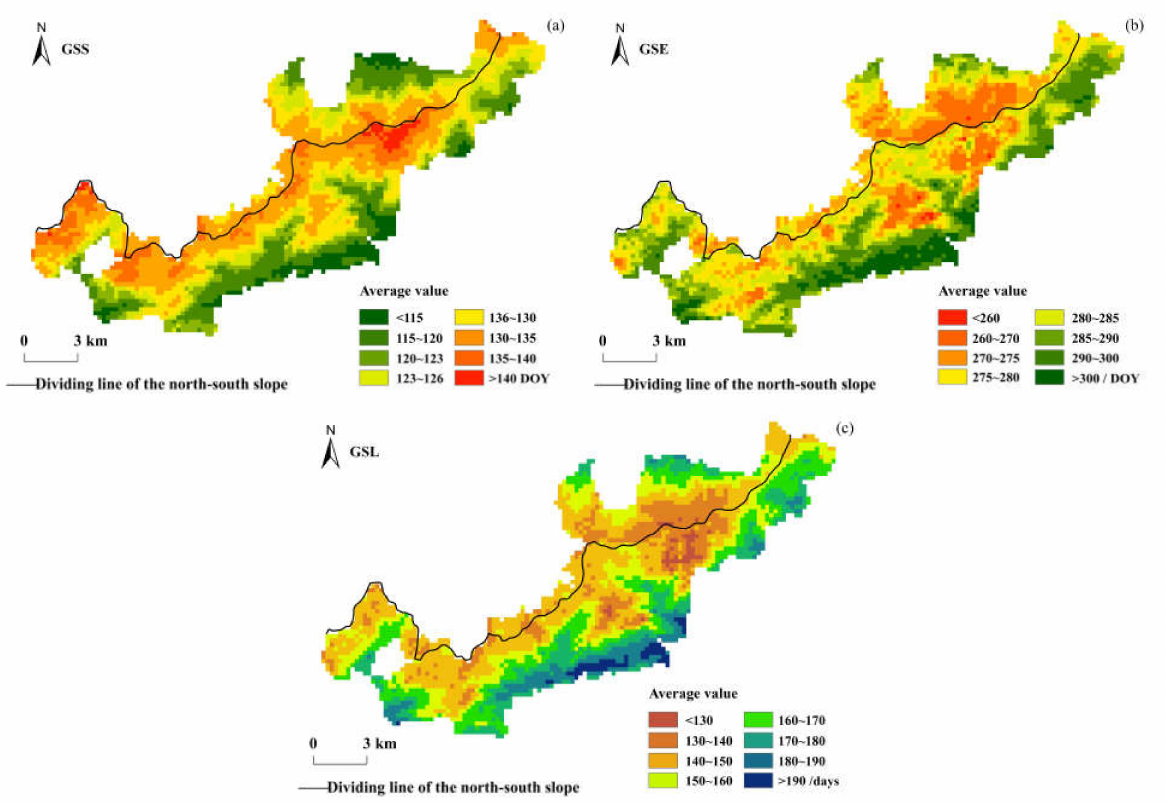
Figure 3. Spatial distribution of the multi-year average of vegetation phenological parameters in Niubeiliang Nature Reserve from 2000 to 2017. ( a ) GSS; ( b ) GSE; ( c )